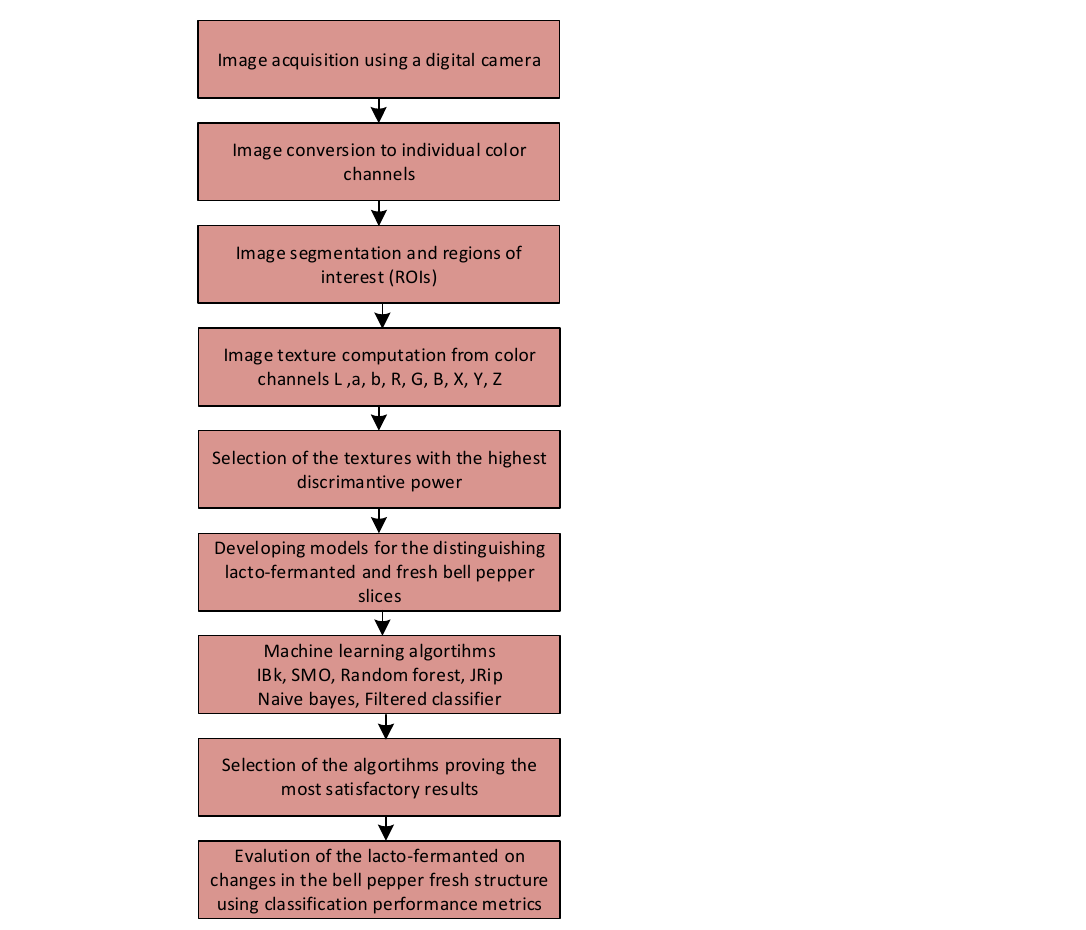
Figure 3. A flowchart presenting steps of distinguishing fresh and lacto-fermented red bell pepper samples using image textures and machine learning algorithms.